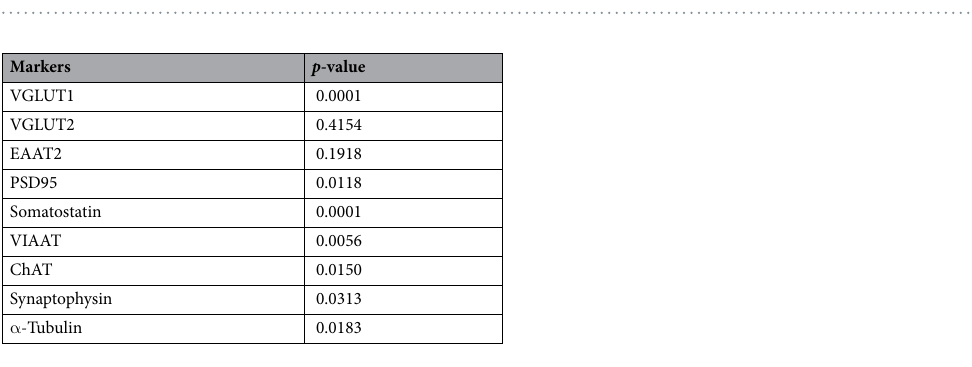
Figure 8. Polyserial and Pearson correlation analyses. Polyserial ( ρ ) and Pearson (r) correlation coefficients between the CDR scores and VGLUT1, VGLUT2, somatostatin (Som), ChAT, VIAAT, EAAT2, α -tubulin, synaptophysin (syn) and PSD95 were determined. The various correlation coefficients were colour coded from dark blue for a correlation of 1 to a deep red for − 1 (and white for 0). Polyserial correlations between the markers and CDR scores are represented by the dashed boxes on the first row. Pearson correlations are presented between the different markers. VGLUT1 shows a negative correlation with the CDR scores, which was higher than that of somatostatin, VIAAT and synaptophysin (r < − 0.3). The Pearson correlations highlighted a positive correlation between VGLUT1 vs. α -tubulin, PSD95 and VIAAT (r > 0.46) and between PSD95 vs. VIAAT and synaptophysin (r > 0.5). The p -values of the Pearson correlation analyses are presented in Table 2.